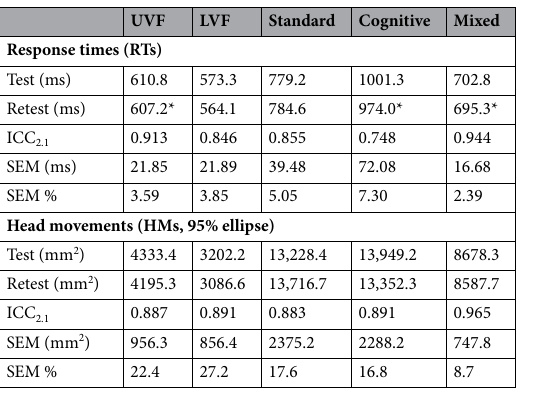
Table 2. Test–retest values and reliability metrics for mean response times and head movement. *p < 0.05 between test and